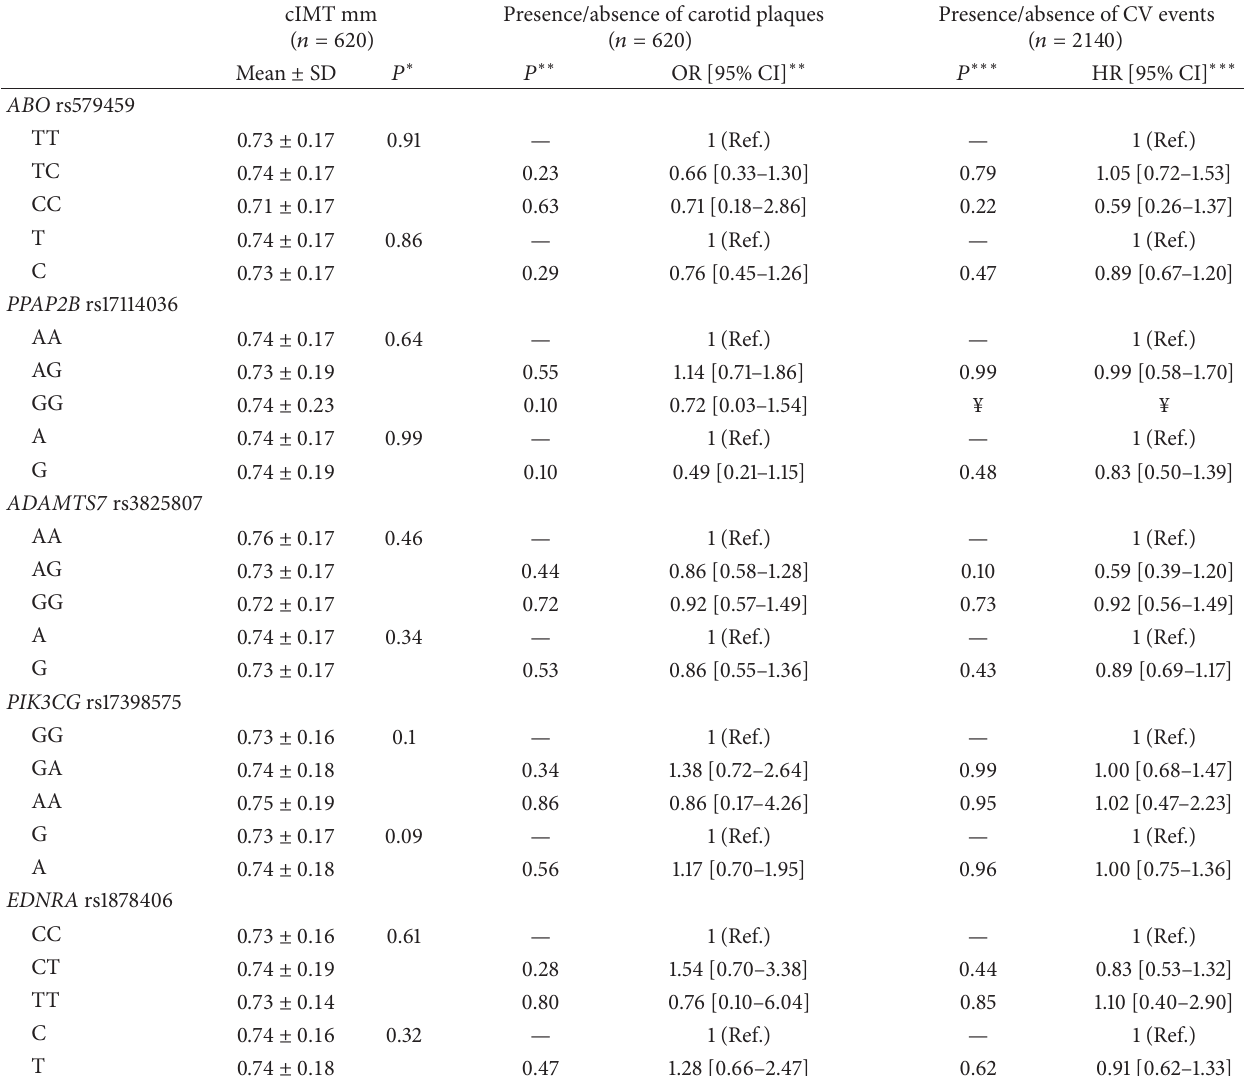
Table 2: Association between AB0, PPAP2B, ADAMTS7, PIK3CG , and EDNRA genotypes and alleles and cIMT, presence/absence of carotid plaques, and CV events in RA